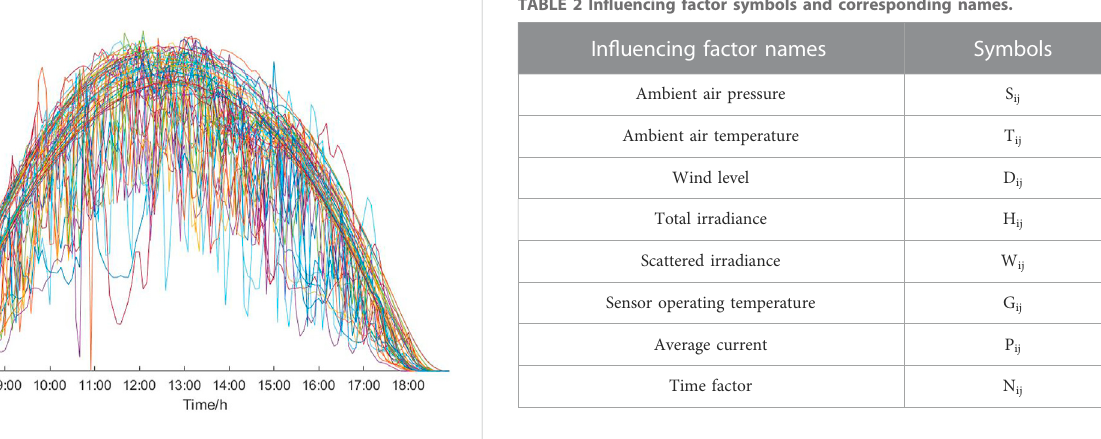
FIGURE 3 90-day PV output power database.